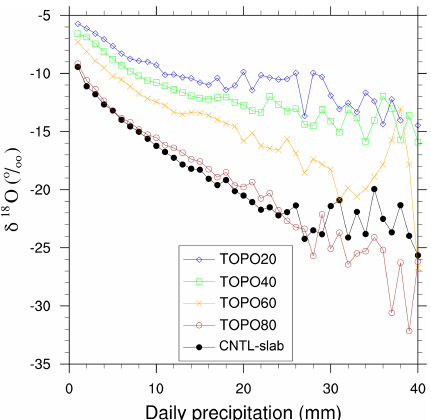
Figure 14. ECHAM δ 18 O p (‰) versus the daily summertime pre- cipitation rate (mmday − 1 ) on the Tibetan Plateau. ECHAM δ 18 O p decreases with increasing precipitation under all elevation scenar- ios, but is greater in high-elevation scenarios than in low-elevation scenarios.